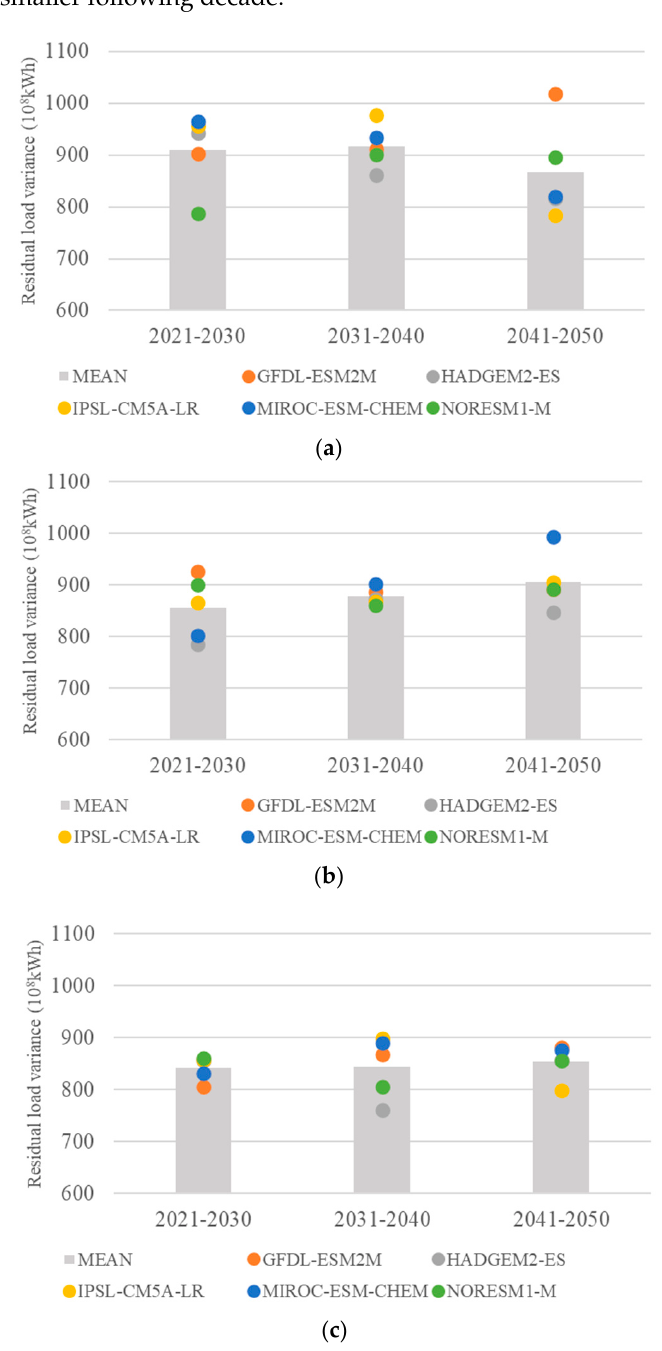
Figure 19. Residual load variance for the next three decades under scenarios: ( a ) RCP2.6, ( b ) RCP4.5, and ( c ) RCP8.5.